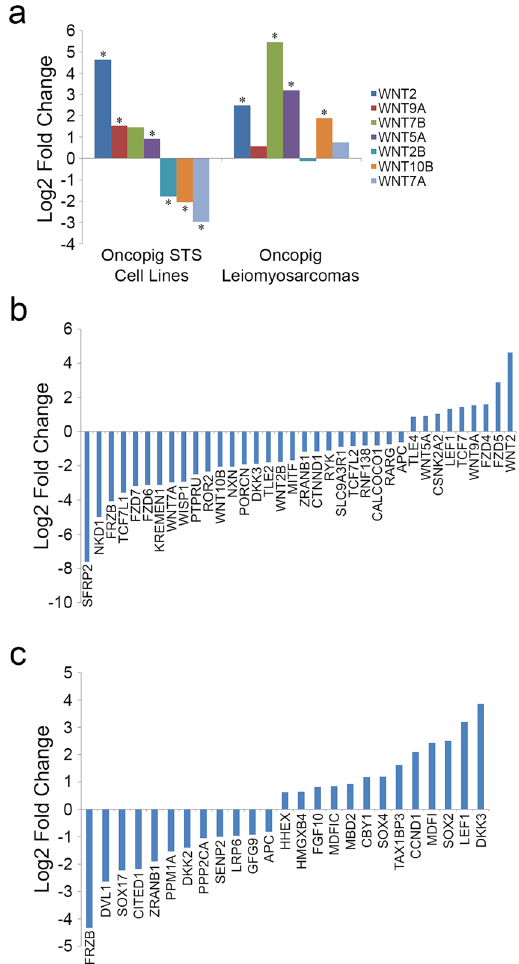
Figure 5. Differential expression of genes involved in Wnt signaling in Oncopig STS. ( a ) Expression of WNTs in Oncopig leiomyosarcomas and STS cell lines relative to controls, represented as the log2 fold change. ( b ) DEGs involved in the Wnt receptor signaling pathway in the Oncopig STS cell lines, represented as the log2 fold change relative to control. ( c ) DEGs involved in the regulation of Wnt receptor signaling pathway in the Oncopig leiomyosarcomas, represented as the log2 fold change relative to control. * denotes q-value <